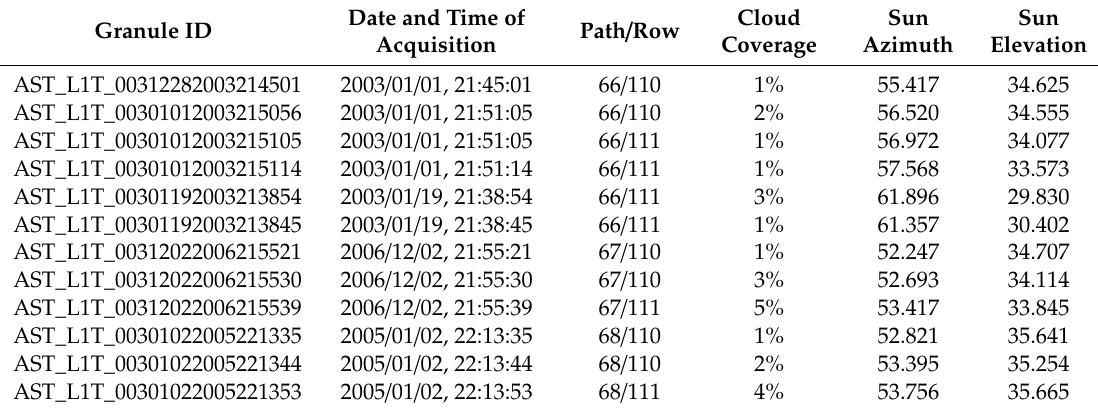
Table 1. The dataset characteristics of ASTER images used in this